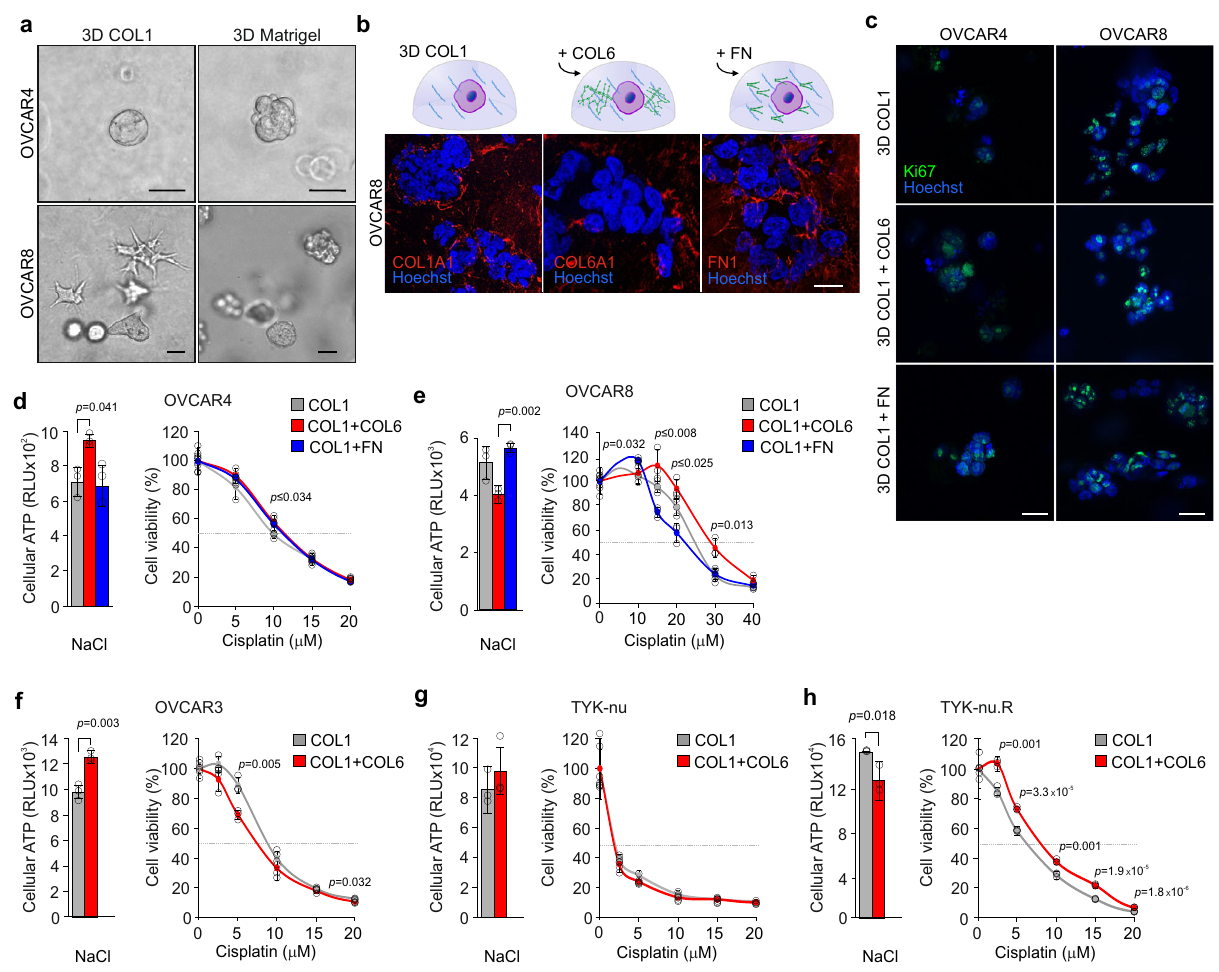
Fig. 6 Addition of collagen 6 promotes HGSC cell survival in 3D collagen 1. a Representative light phase-contrast images show the diverse growth phenotype response of OVCAR4 and OVCAR8 cultured in 3D collagen 1 (COL1) and Matrigel for 5 days. Scale bar = 25 µ m. b Schematic diagram of the experimental design and representative confocal micrographs of COL1A1, COL6A1, and fi bronectin (FN1) in OVCAR8 grown for 5 days in 3D COL1 with or without 50 µ g/ml COL6 or FN supplementation. Scale bar = 25 µ m. c Representative confocal micrographs of Ki67 (green) show the comparable proliferation in OVCAR4 and OVCAR8 between all corresponding 3D matrix cultures. Cells were grown for 5 days. See Supplementary Fig. 13b, c for quanti fi cations. Scale bar = 25 µ m. d – h Bar charts depict cellular ATP in OVCAR4 ( d COL1 vs COL1 + COL6 p = 0.016 vs COL1 + FN p = 0.034), OVCAR8 ( e COL1 + COL6 vs COL1 + FN at 10 µ M p = 0.005, at 20 µ M p = 0.004, at 30 µ M and vs COL1 p = 0.013; COL1 vs COL1 + FN at 10 µ M p = 0.008,